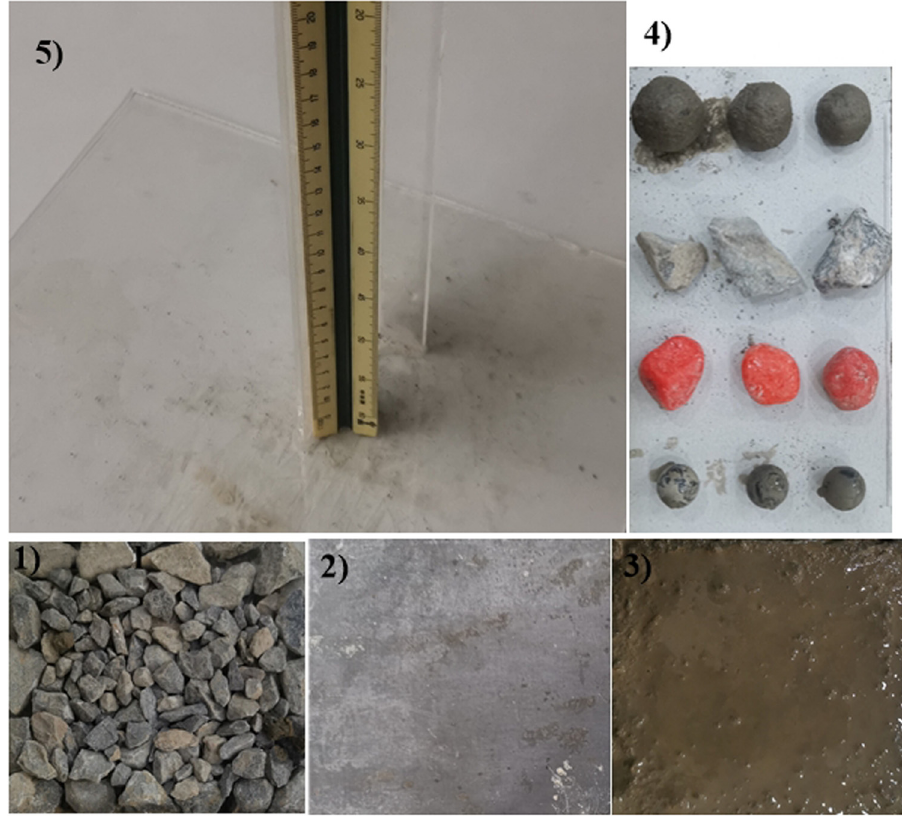
Figure 3: Measurement of the coe ffi cient of restitution: particle plates: ( 1 ) gravel, ( 2 ) steel, ( 3 ) mortar, ( 4 ) selected particle, and ( 5 ) measuring drop height